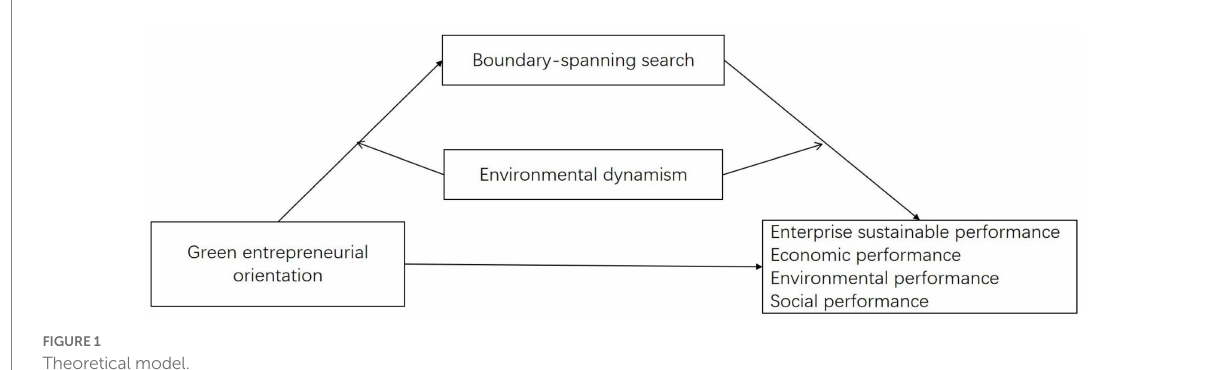
FIGURE 1 Theoretical